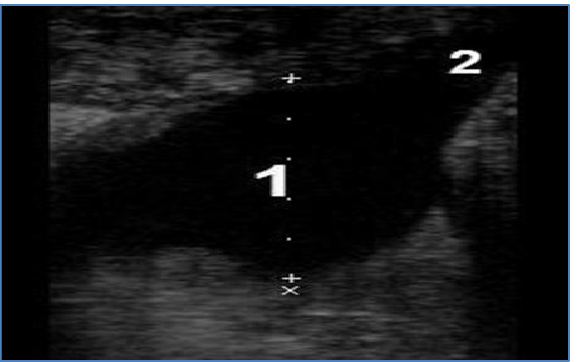
Figure, 7: Per-rectum ultrasonogram of normal size and position of buffalo urinary bladder filled with urine,